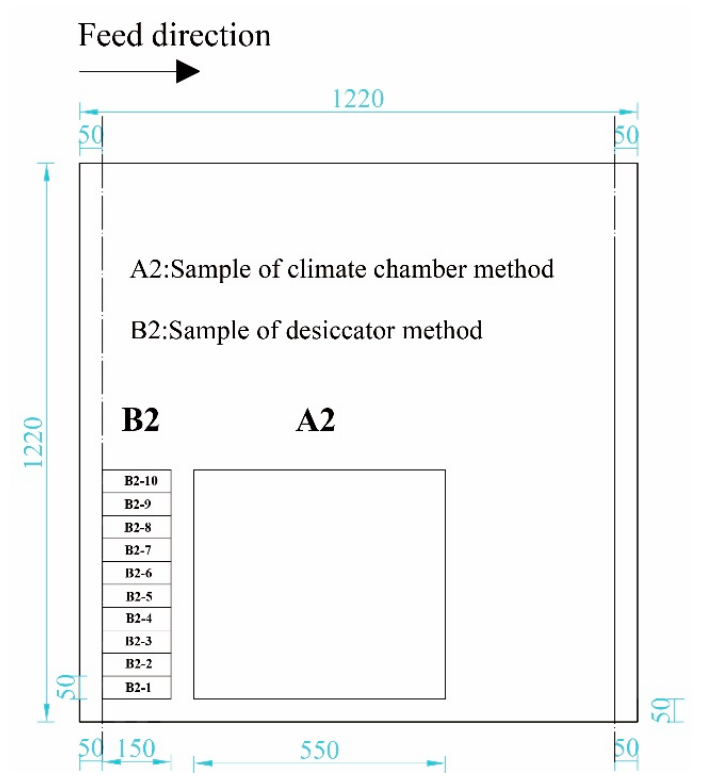
Figure 2. Sampling diagram of sample 1.